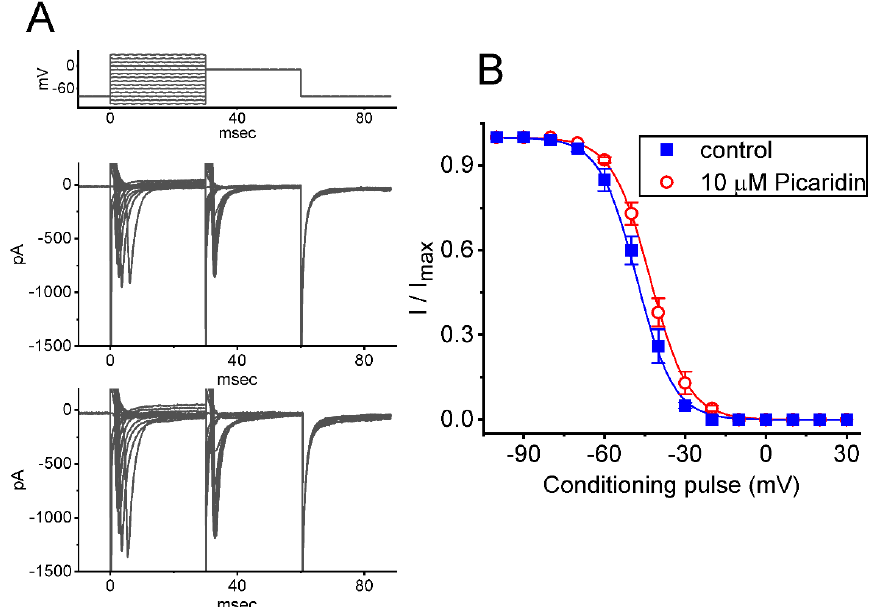
Figure 3. Modification by picaridin on steady-state inactivation curve of I Na(T) identified from GH 3 cells. This set of experiments was undertaken in situations where conditioning voltage pulses with a duration of 30 ms to various potentials, ranging between − 100 and +30 mV, were applied from a holding potential of − 80 mV. Following each conditioning pulse, a test pulse to − 10 mV for a duration of 30 ms was, subsequently, applied to evoke I Na(T) . An example of current traces obtained by a two-pulse protocol in the control period (upper) and during the exposure to 10 µ M picaridin (lower) is illustrated in ( A ). The uppermost part is the voltage protocol given. ( B ) Quasi-steady-state inactivation curves of I Na (T) obtained with the absence (blue filled squares) and presence (red open circles) of 10 μM picaridine (mean ± SEM; n = 7 for each point). The normalized amplitude of I Na(T) (i.e., I/I max ) was constructed against the different levels of conditioning potential, and the sigmoidal curves (blue and red lines) were fitted to the Boltzmann equation (see Materials and Methods).